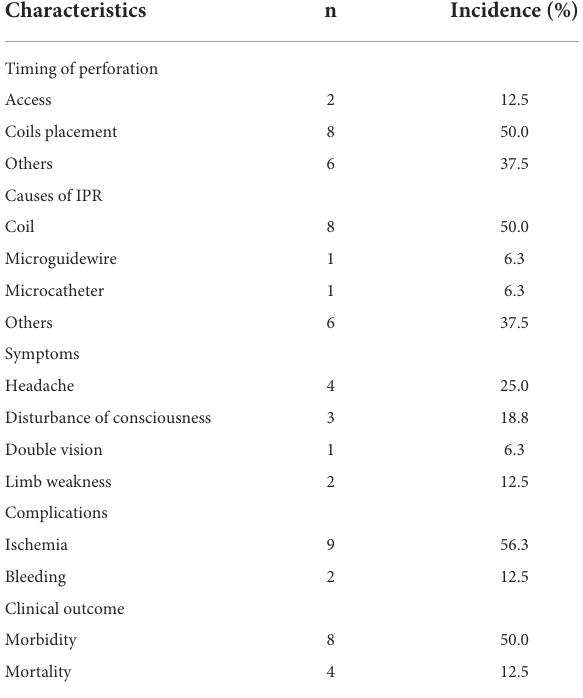
TABLE 4 Risk score (S-V-A score, 0-3 points) for